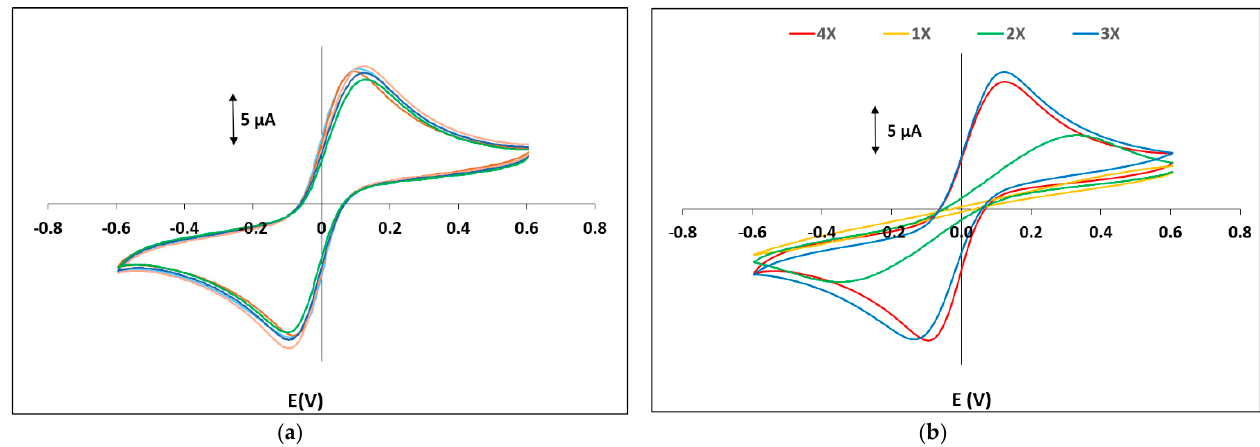
Figure 4. CVs of a 2.0 mmol L − 1 potassium ferrocyanide/ 2.0 mmol L − 1 potassium ferricyanide solution in 0.01 mol L − 1 KCl ( a ) of 5 different electrochemical PADs and ( b ) electrochemical PADs with 1, 2, 3 and 4 passes with the grade 5B pencil (pen No 17; paper 7; single-sided plotting; 2 passes; pen plotting speed 2.7 cm s − 1 ; pencil plotting speed 32 cm s − 1 ).